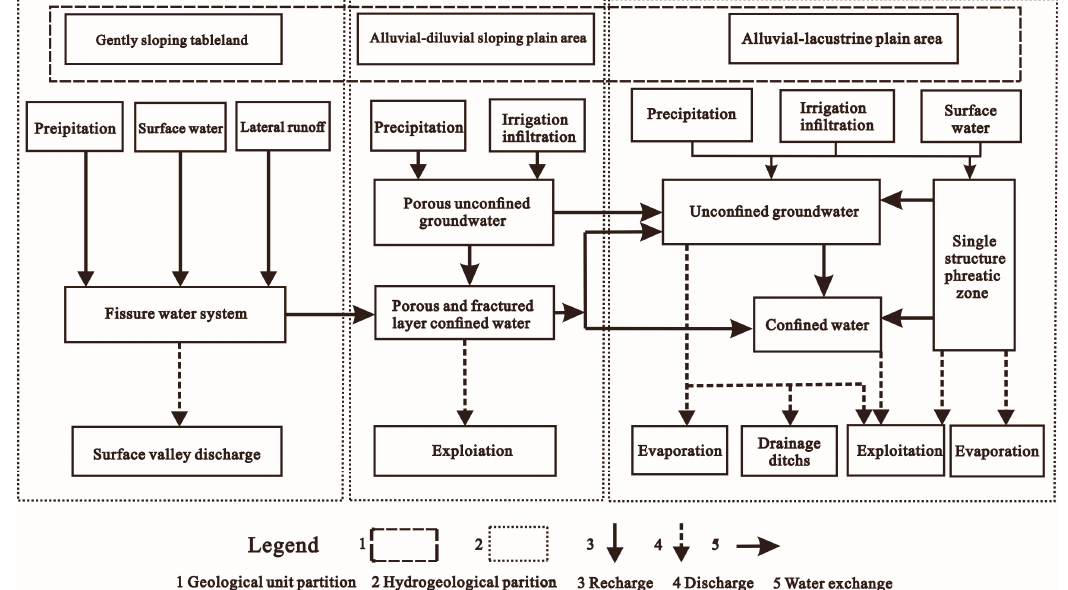
Figure 9. Qualitative groundwater circulation in the study area.